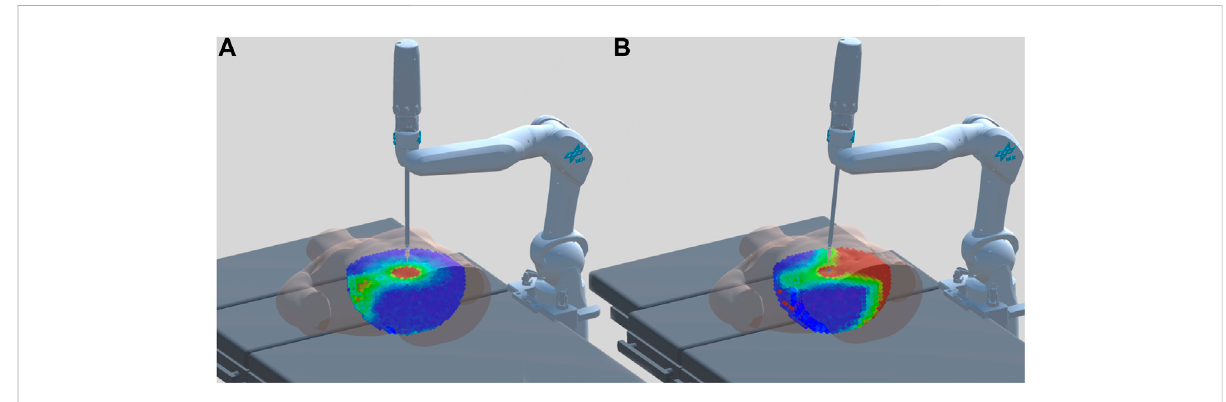
FIGURE 10 Visualization of the derived RASSCMAPs for constrained procedures for two different access points and fi xed base pose. (A) Best-suited access point. (B) Worst-suited access